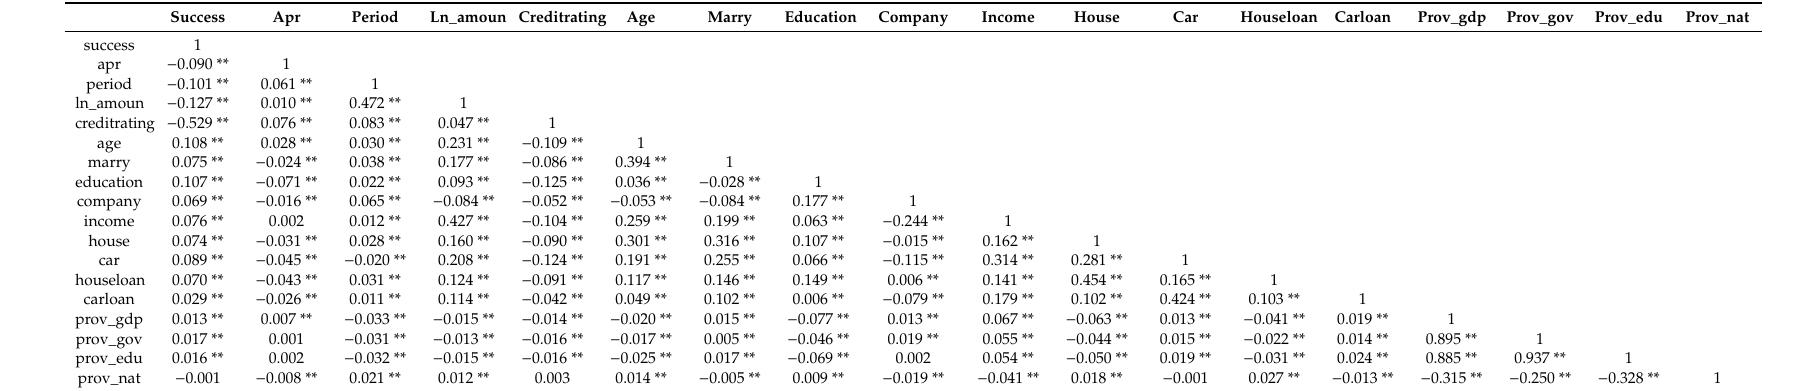
Table A1. Variable Pearson correlation coe ffi cient